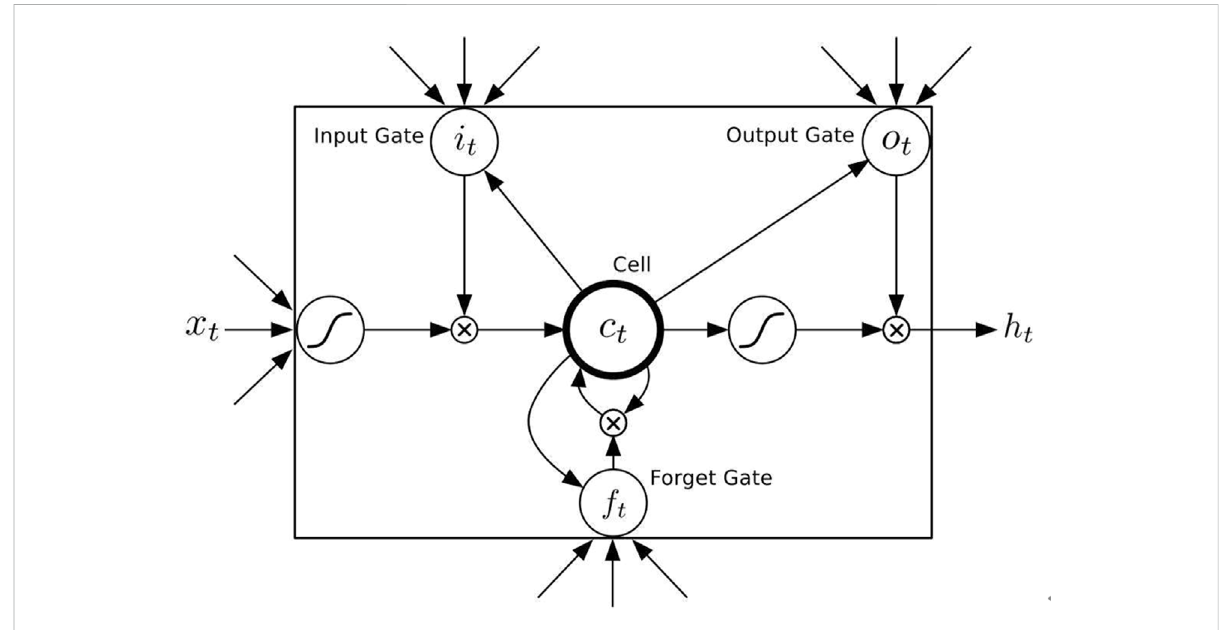
FIGURE 1 The basic network structure of